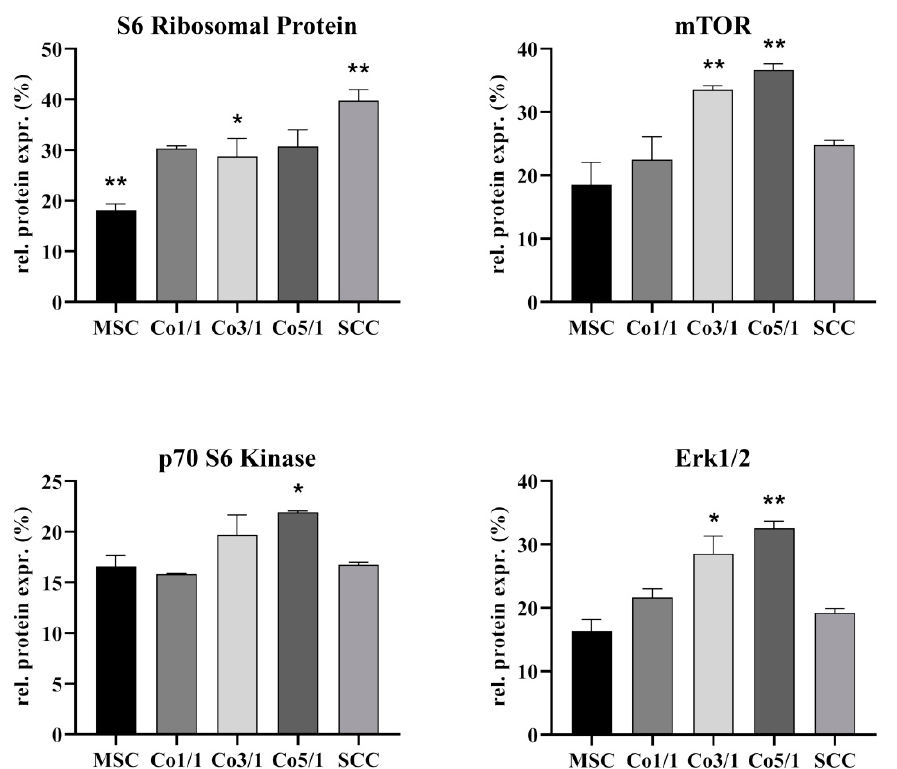
Figure 6. Protein level analysis of S6 ribosomal protein, mTOR, p70 S6 kinase, and Erk1/2 in MSCs, Co1/1, Co3/1, Co5/1, and SCCs (** = p ≤ 0.01, * = p ≤ 0.05).